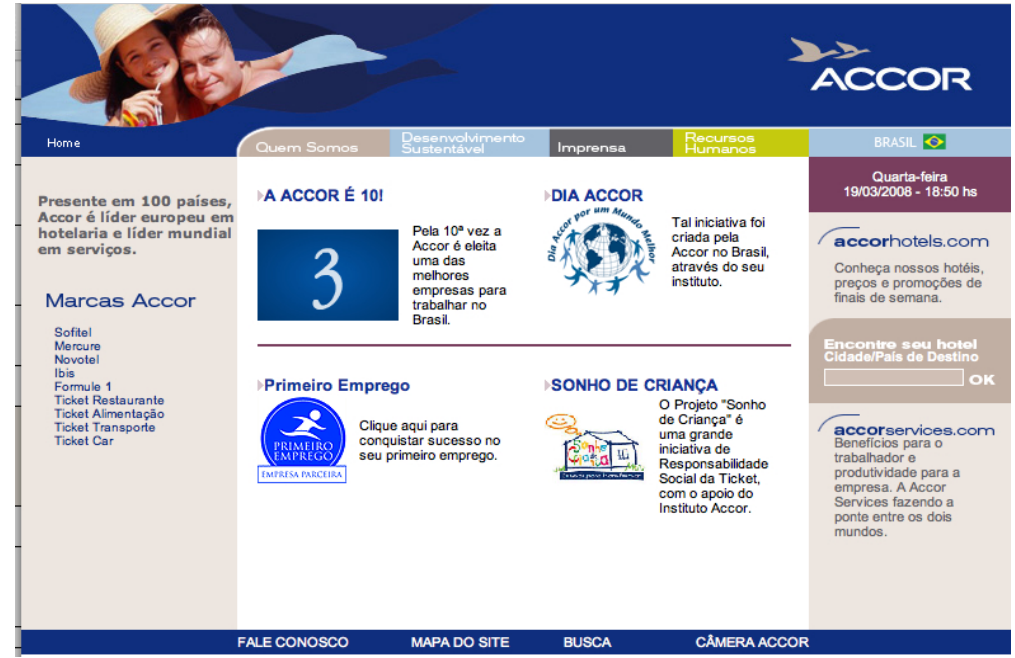
Figure 3. Screenshot of Accor Brazil main